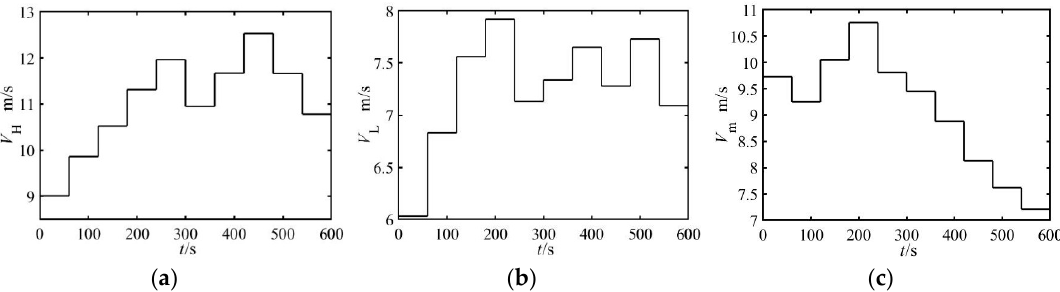
Figure 5. Load fluctuation curves in three areas. ( a ) Area1. ( b ) Area2. ( c ) Area3.